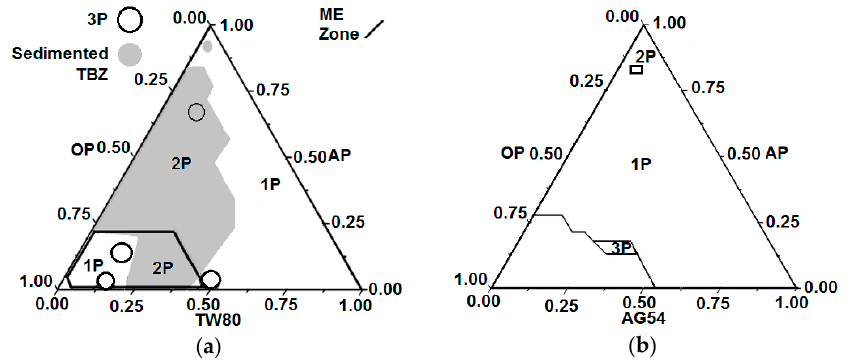
Figure 2. Pseudo-ternary phase diagrams of the systems at T = 25 °C: ( a ) OP//TW80//AP and ( b ) OP//AG54//AP.